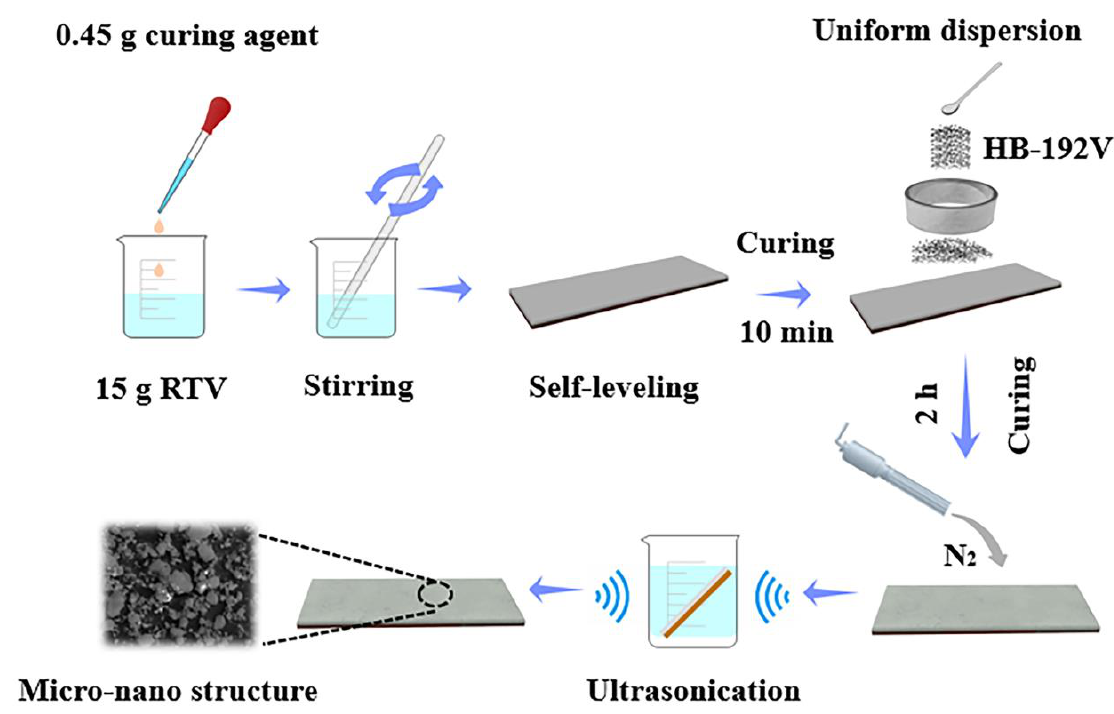
Figure 2. Preparation process of fluororubber superhydrophobic surface.